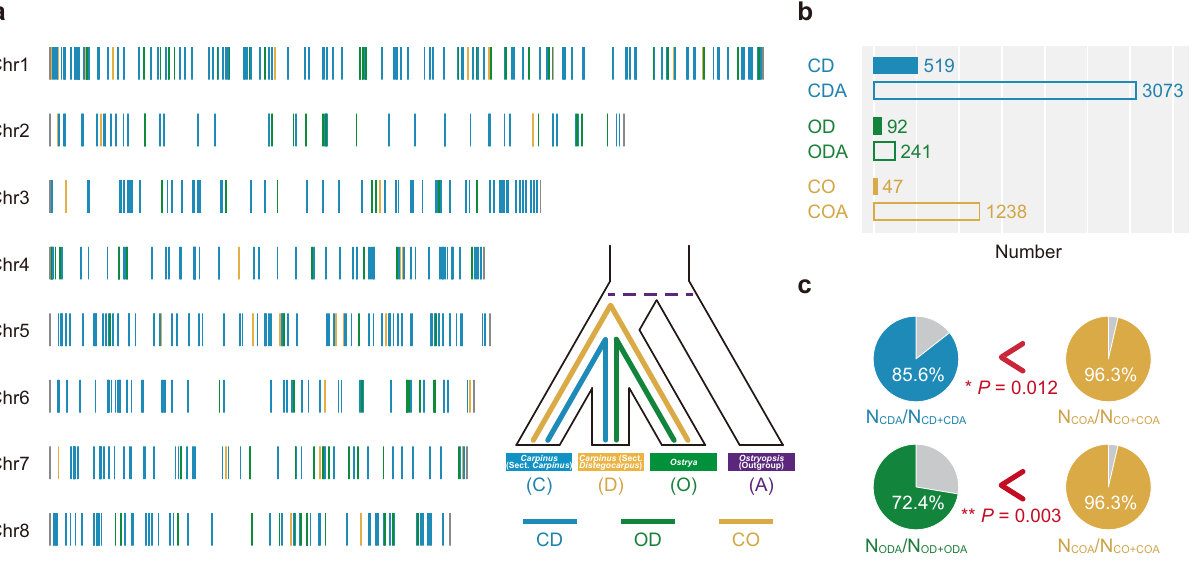
Fig. 5 PIVs across the genome. a PIVs identi fi ed across the genome based on population genomic data. b Number of PIVs ( “ CD ” , “ OD ” , and “ CO ” ) and AVs ( “ CDA ” , “ ODA ” , and “ COA ” ) shared by different combinations of lineages. The exact numbers are shown on the right of bar charts. c Signi fi cant PIV signals were detected in both groups ( P = 0.012 and 0.003 respectively), revealing the homoploid hybrid origin of sect. Distegocarpus . Statistical signi fi cance was determined by a Pearson ’ s Chi-square test with Yates ’ correction for continuity. Signi fi cant differences are indicated with asterisks ( * P < 0.05; ** P < 0.01). Sect. Carpinus , sect. Distegocarpus , Ostrya , and Ostryopsis (outgroup) are identi fi ed as “ C ” , “ D ” , “ O ” , and “ A ” , respectively. Different combinations of the letters indicated PIVs ( “ CD ” , “ OD ” , and “ CO ” ) and AVs ( “ CDA ” , “ ODA ” , and “ COA ” ) shared by different combinations of the lineages. The different colors denote sect. Distegocarpus sharing indels (PIVs or AVs) with sect. Carpinus ( “ CD ” or “ CDA ” , blue), Ostrya ( “ OD ” or “ ODA ” , green), or sect. Carpinus sharing indels with Ostrya ( “ CO ” or “ COA ” , yellow) as the graphic examples show. Source data are provided as a Source Data fi